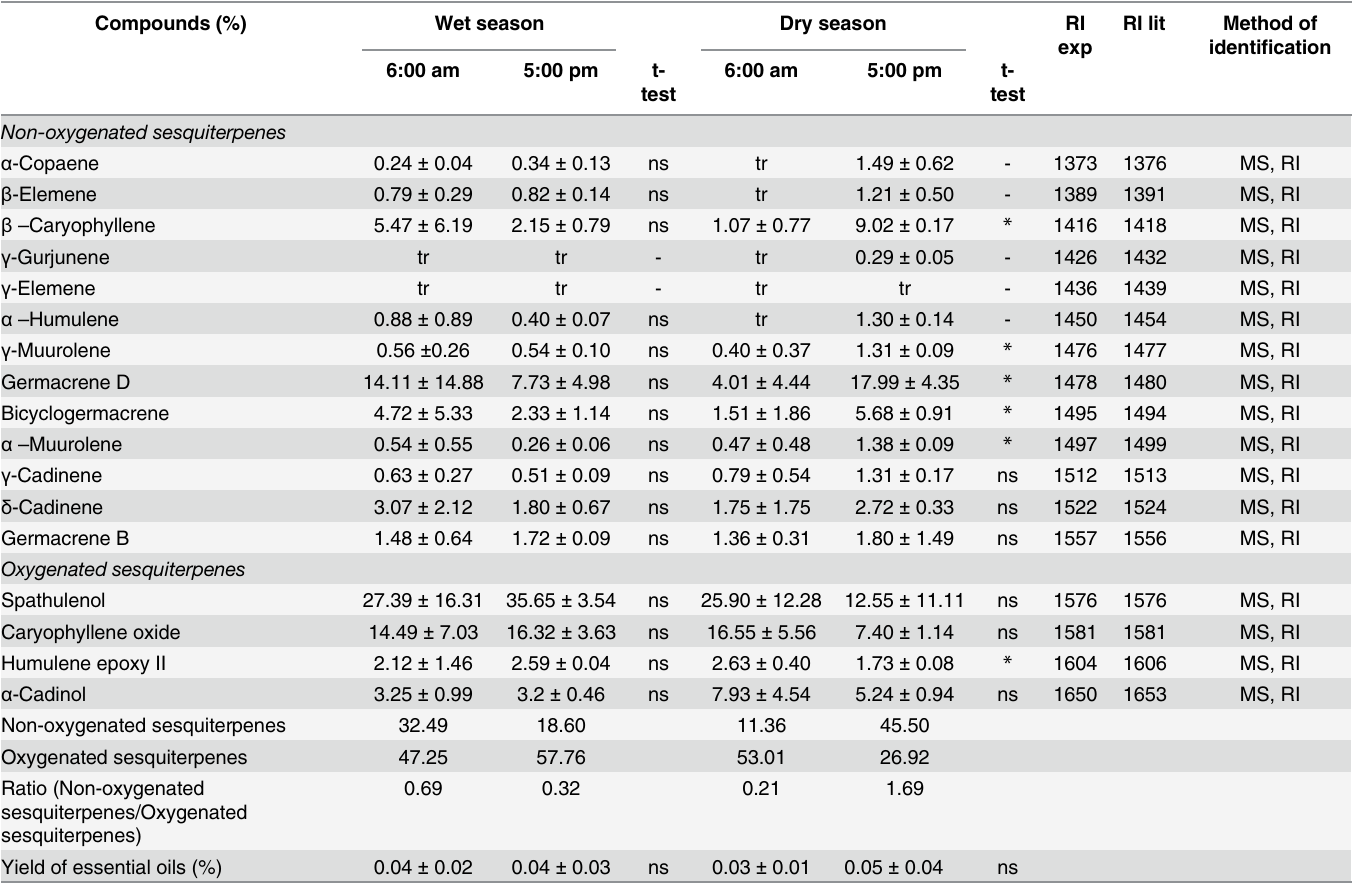
Table 1. Average of essential oil composition and yield of Copaifera langsdorffii Desf. from a semideciduous seasonal forest at 6:00 am and 5:00 pm during the wet and dry seasons. Compounds